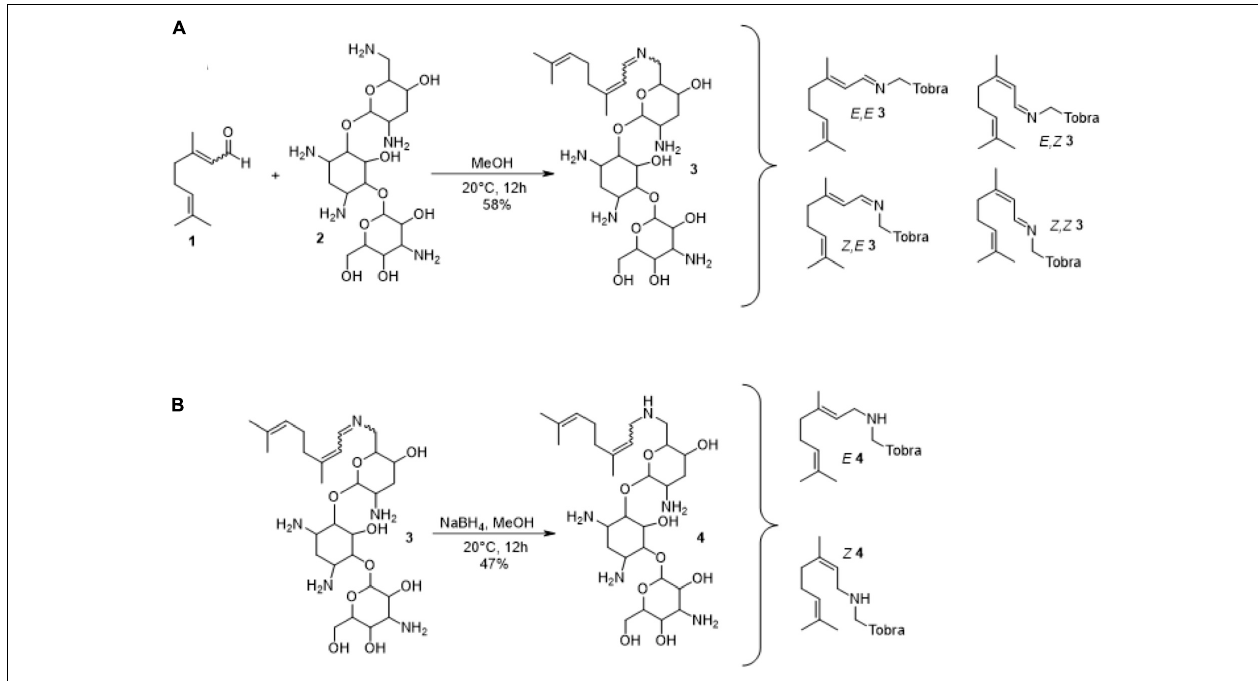
FIGURE 8 | Synthesis of tobracitryl resulting from the condensation of citral with tobramycin. (A) Synthesis of tobracitryl 3 (mixture of four isomers), (B) Reduction of tobracitryl 3 in tobracitryl 4 (mixture of two isomers). The proposed structures are the most probable according to the fact that the amine group N-6’ is the most reactive due to its highest pKa (Alkhzem et al.,